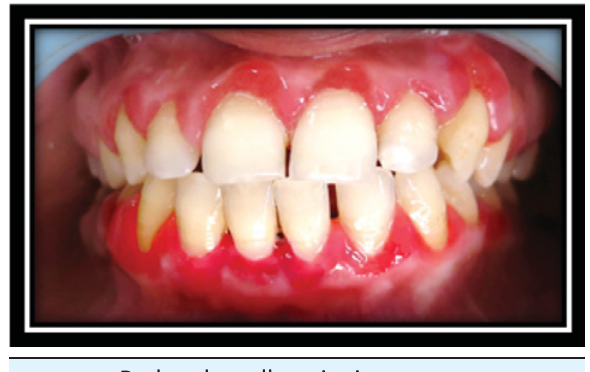
Figure 1. Red and swollen gingiva